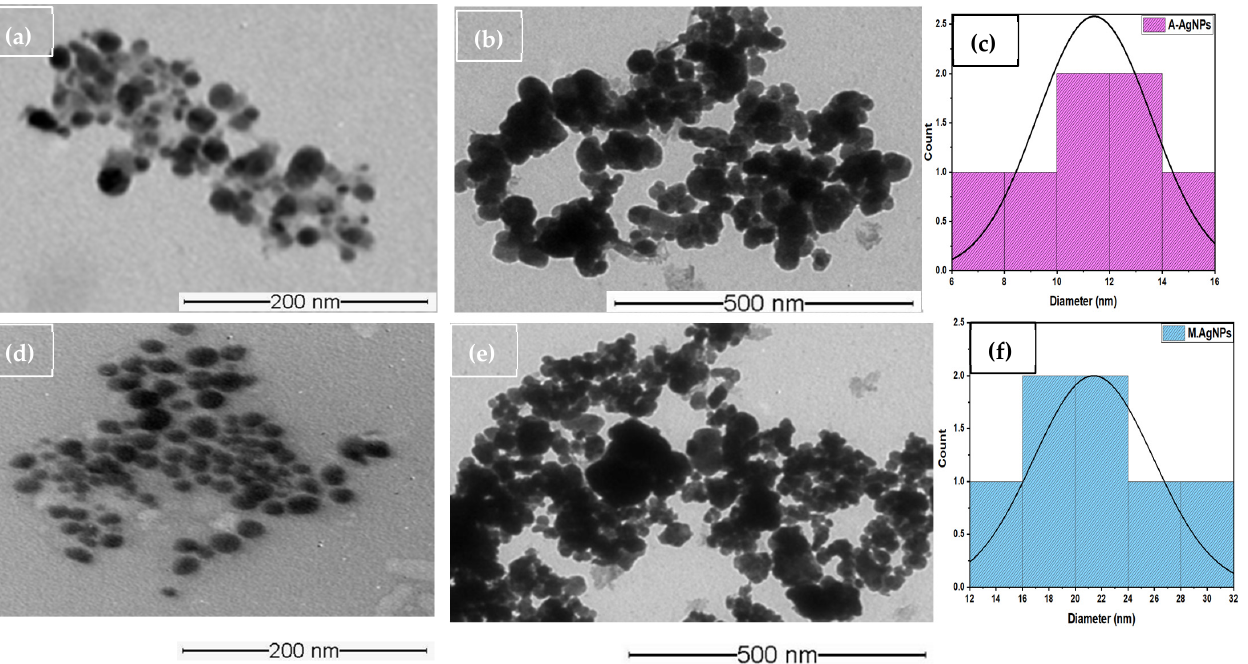
Figure 6. TEM images of spherical monodisperse nanoparticles produced using A. indica and M. indica . ( a – c ) A-AgNPs under higher magnification and low magnification, as well as a histogram plot representing the average size of NPs; ( d – f ) High-magnification and low-magnification images, with histogram presenting the size of the M-AgNPs.